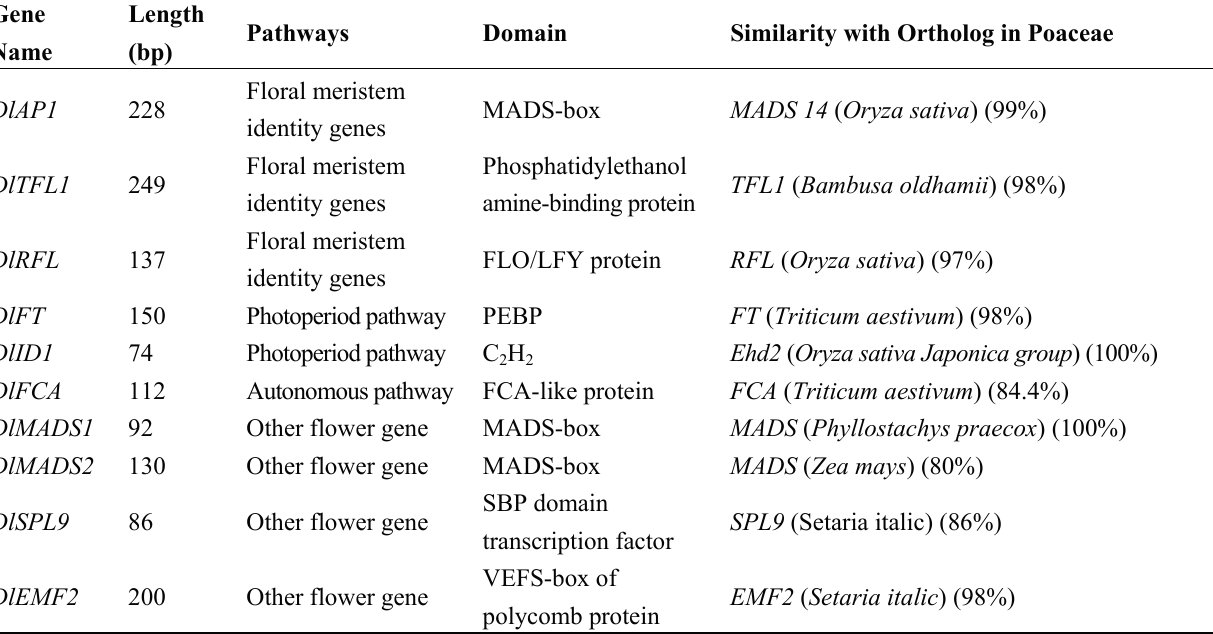
Table 2. Isolation and analysis of the ten candidate genes. PEBP, phosphatidylethanolamine-binding protein.